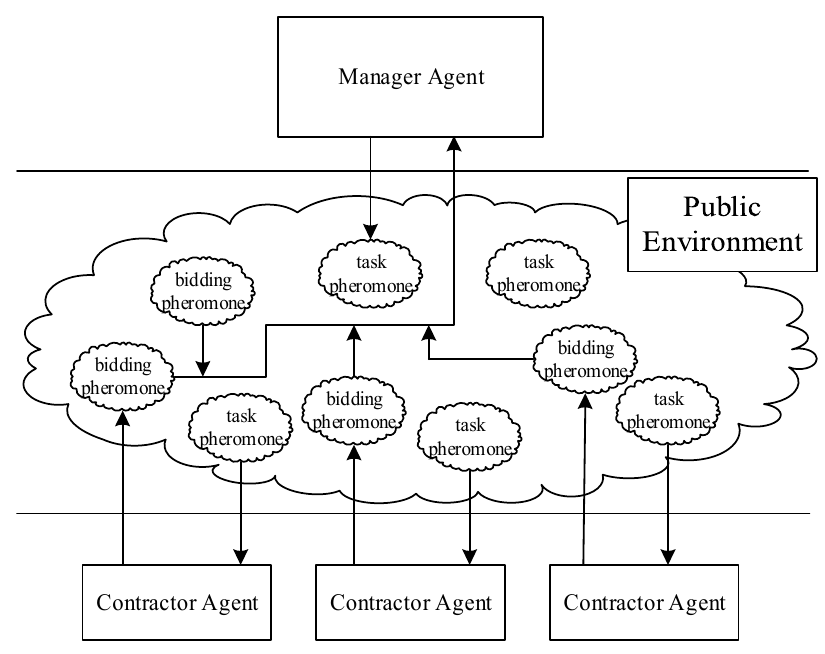
Figure 2. The flow of pheromones.